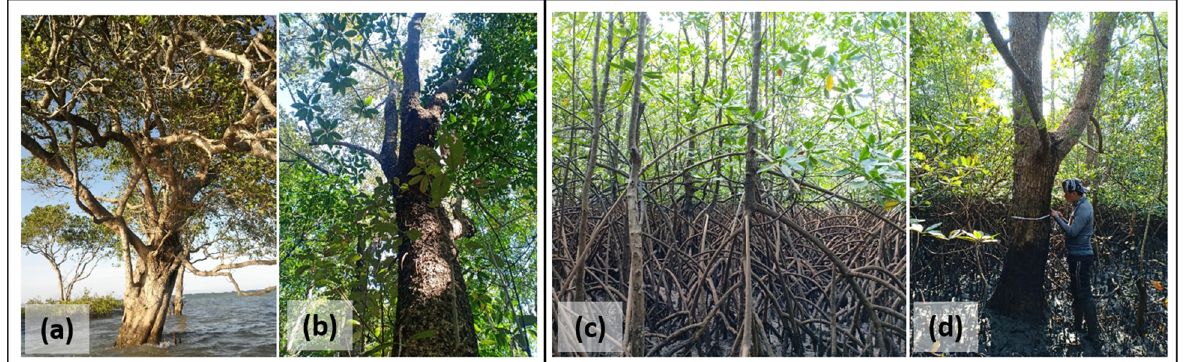
Figure 8. General features of ( a ) matured Sonneratia alba (L.) Smith and ( b ) matured Avicennia marina (Forsk.) Vierh. var. rumphiana (Hallier) Bak in the natural stand; ( c ) Rhizopora sp . and ( d ) matured Sonneratia alba (L.) Smith in the reforestation site.